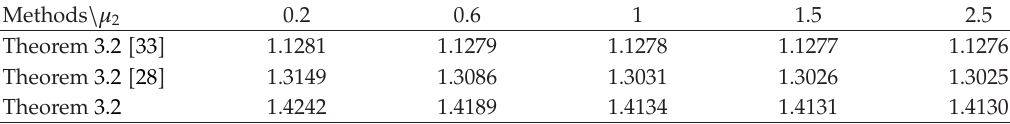
(cid:8) 0 . 2 in Example 4.4. 2 , and δ 0